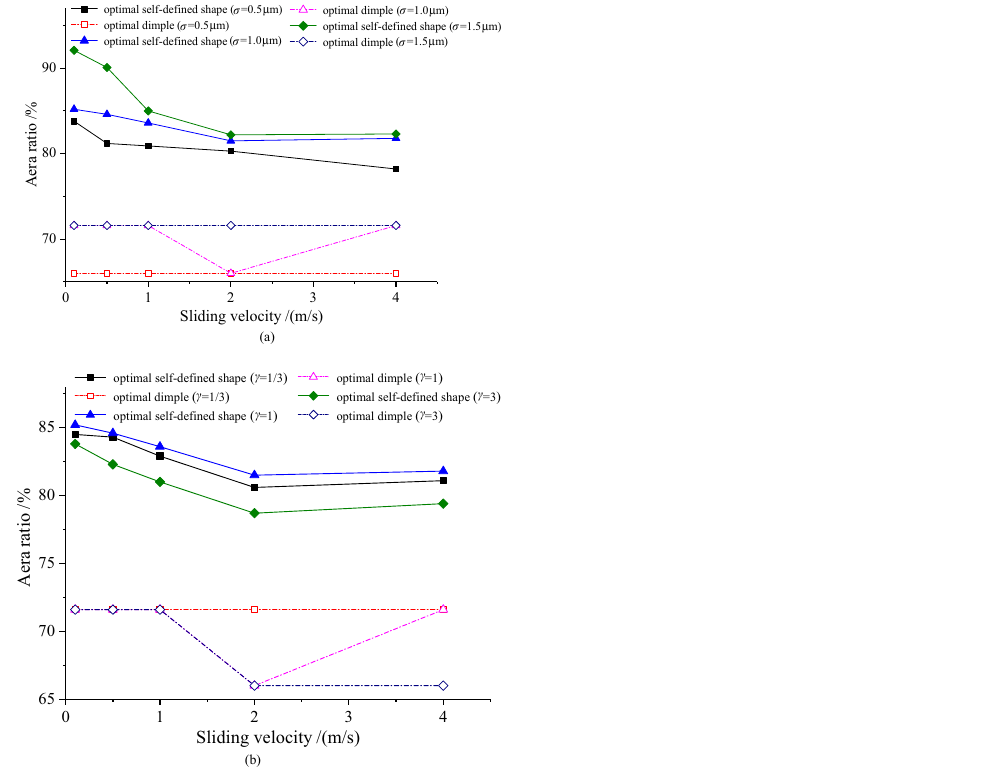
Figure 12. Variation of the area ratio with sliding